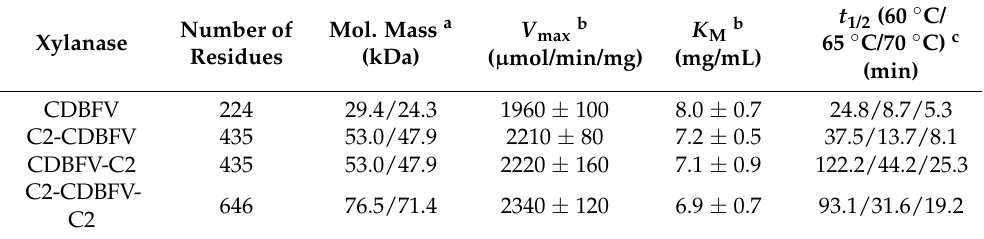
Table 1. Molecular and catalytic characteristics and thermal stability of the four